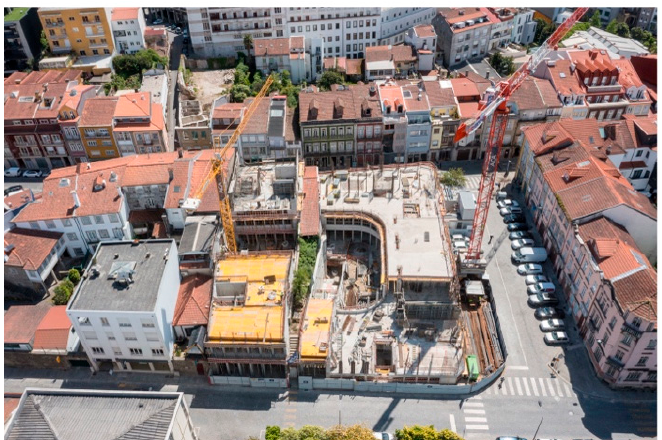
Figure 3. Braga. Aerial view.